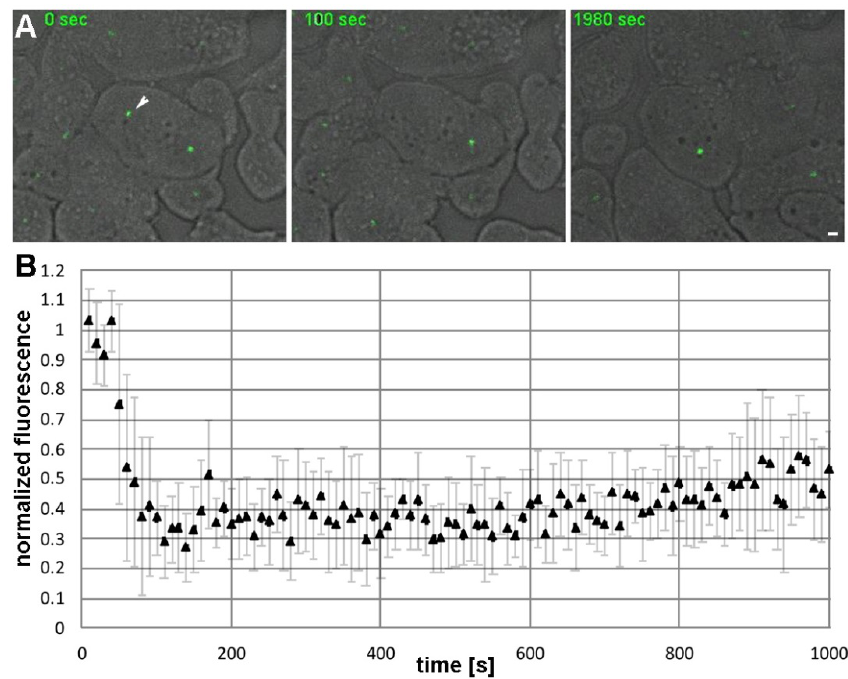
Figure 4. GFP-CDK5RAP2ki shows hardly any recovery after photobleaching. ( A ) Confocal spinning disk live cell imaging of GFP-CDK5RAP2ki cells. Selected time points from Video S2 are displayed. A maximum intensity projection of three confocal slices (z-distance 0.25 µm) is shown. The bleached centrosome is highlighted by an arrowhead. Cells were viewed under agar overlay [35]. Bar = 2 µm. ( B ) FRAP curve mean intensity values and error bars indicating SD ( n = 10) are plotted against time.